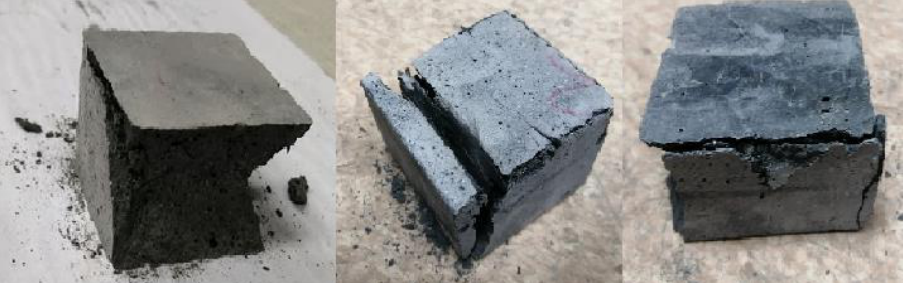
Figure 14. Fly ash and sand-based geopolymer samples (10M NaOH solution) after compression test, reinforced with short carbon fiber (5 mm).